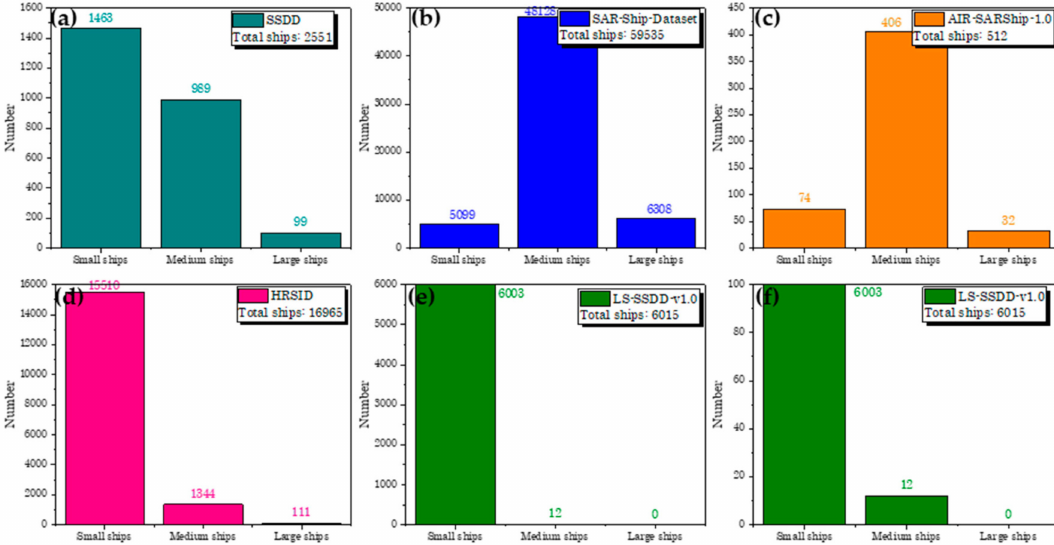
Figure 12. The number of di ff erent size ships in di ff erent datasets. ( a ) SSDD; ( b ) SAR-Ship-Dataset; ( c ) AIR-SARShip-1.0; ( d ) HRSID; ( e ) LS-SSDD-v1.0; ( f ) coordinate axis enlarged display of ( e ).